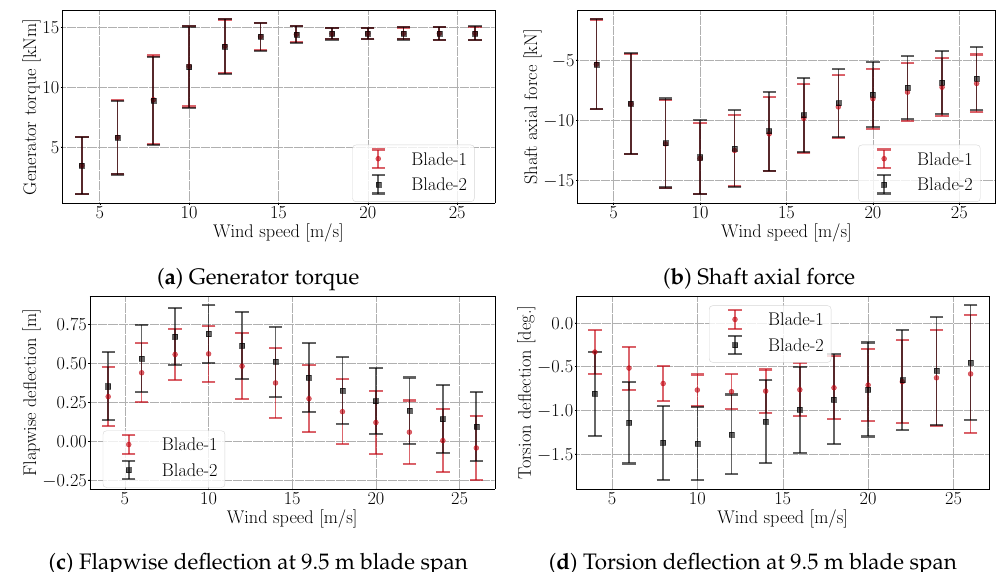
Figure 18. Mean and standard deviation values for generator torque, shaft axial force, flapwise, and torsion deflections at 9.5m blade span for DLC1.3.